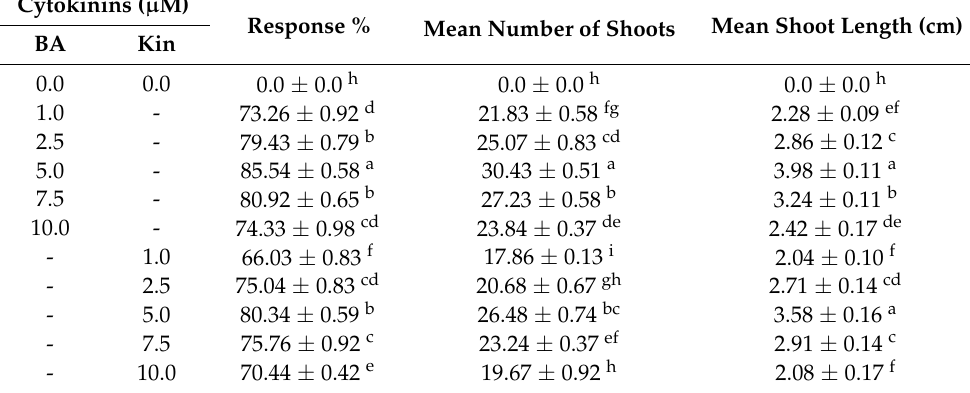
Table 2. Effect of cytokinins on shoot multiplication in callus mass obtained from internodal explants after 8 weeks of